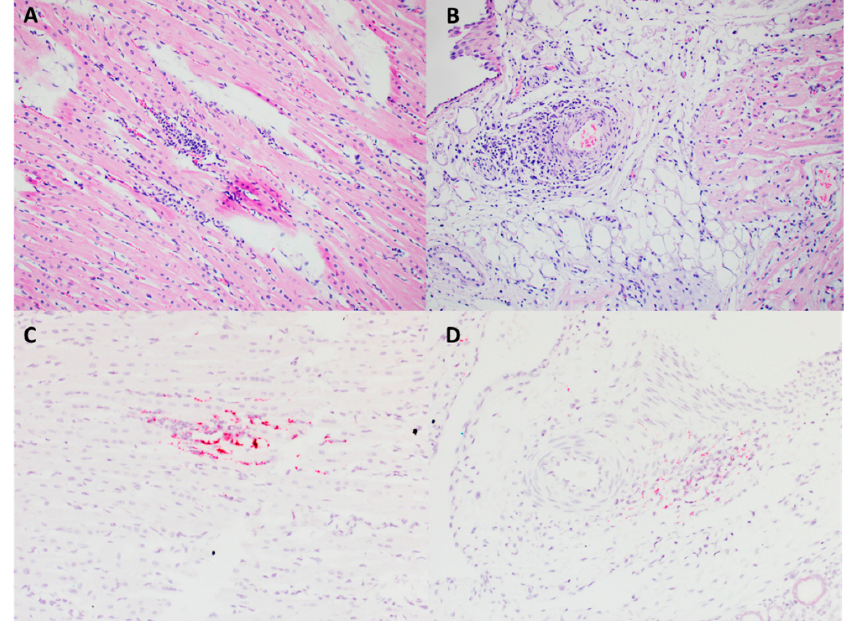
Figure 7. Microscopic lesions and RNAscope in situ hybridization (ISH) on tissues collected at necropsy (28 dpi) from 6-weeks-old CD / CD PCV3 inoculated pigs. The myocardium is multifocal infiltrated by small aggregates of lymphocytes and plasma cells. H&E (20 × ) ( A ). The tunica adventitia and media of multiple arterioles of the heart are infiltrated by lymphocytes and plasma cells. H&E (20 × ) ( B ). PCV3 was confirmed by ISH in the cytoplasm of cardiomyocytes and inflammatory and endothelial cells. H&E counterstain (20 × ) ( C ). Virus replication was detected by ISH within smooth muscle of arteries. H&E counterstain (20 × ) ( D